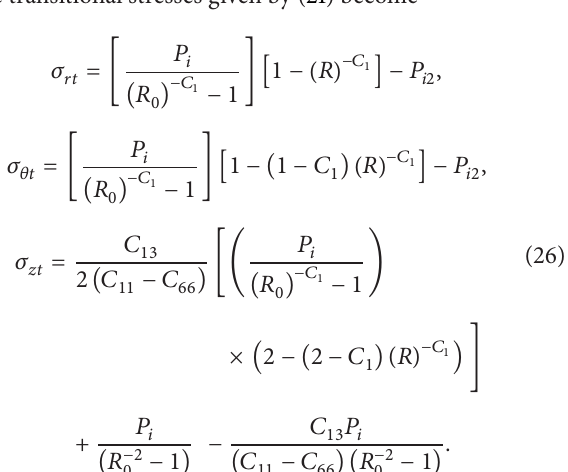
Figure 2: Effective pressure required for initial yielding for isotropic (steel) and transversely isotropic material (beryl and